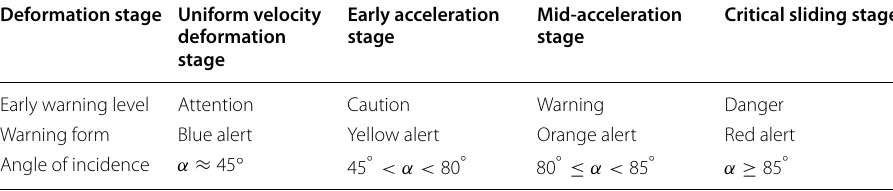
Table 1 Improved tangent angle criteria for landslide warning